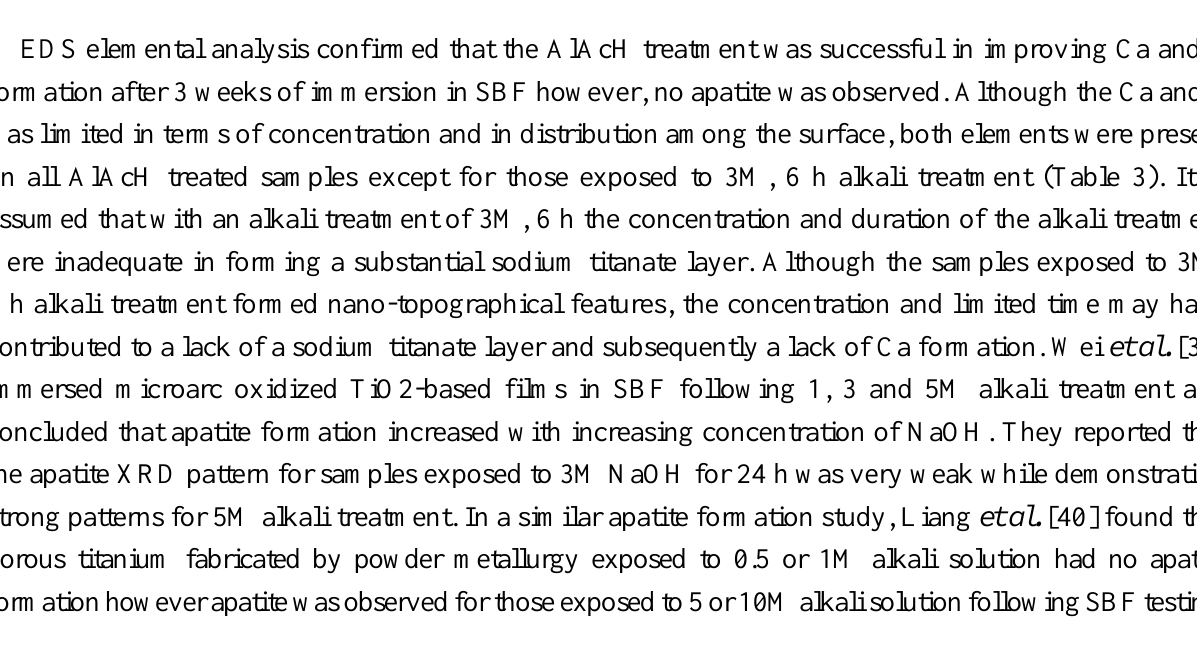
Figure 4. SEM micrograph of cross-sectioned 3M, 6 h AlAcH treated sample at ( a ) 2kX and ( b ) 20kX.